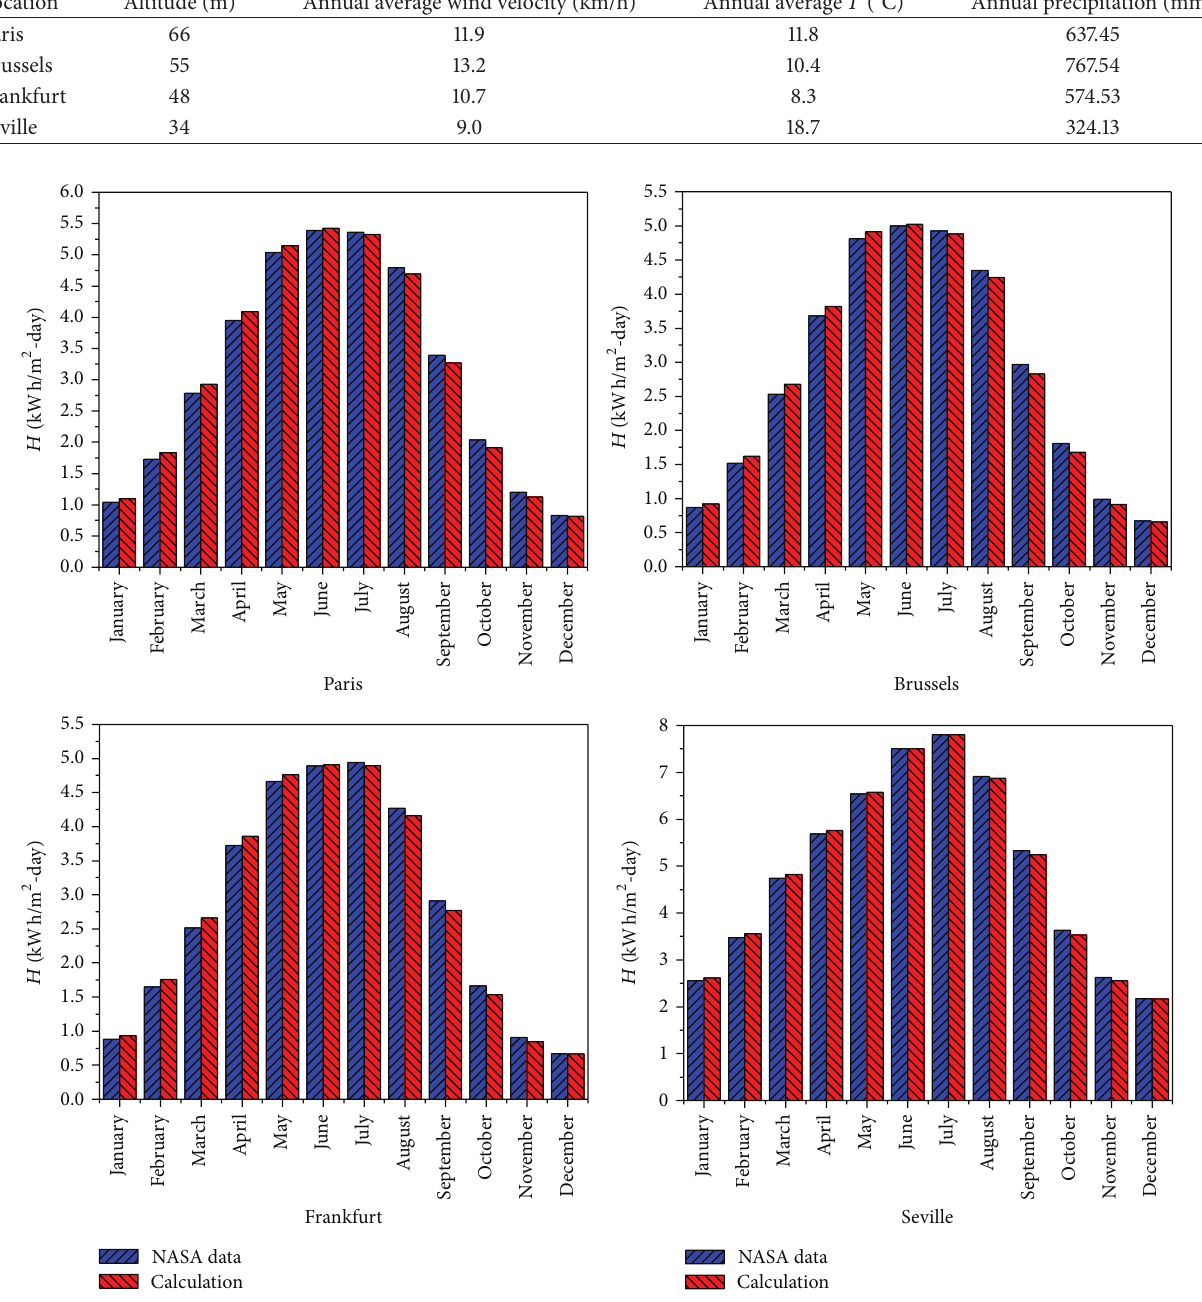
Figure 3: Monthly NASA solar irradiation (blue rectangle) and model-calculated data (red rectangle) for Brussels, Seville, Paris, and